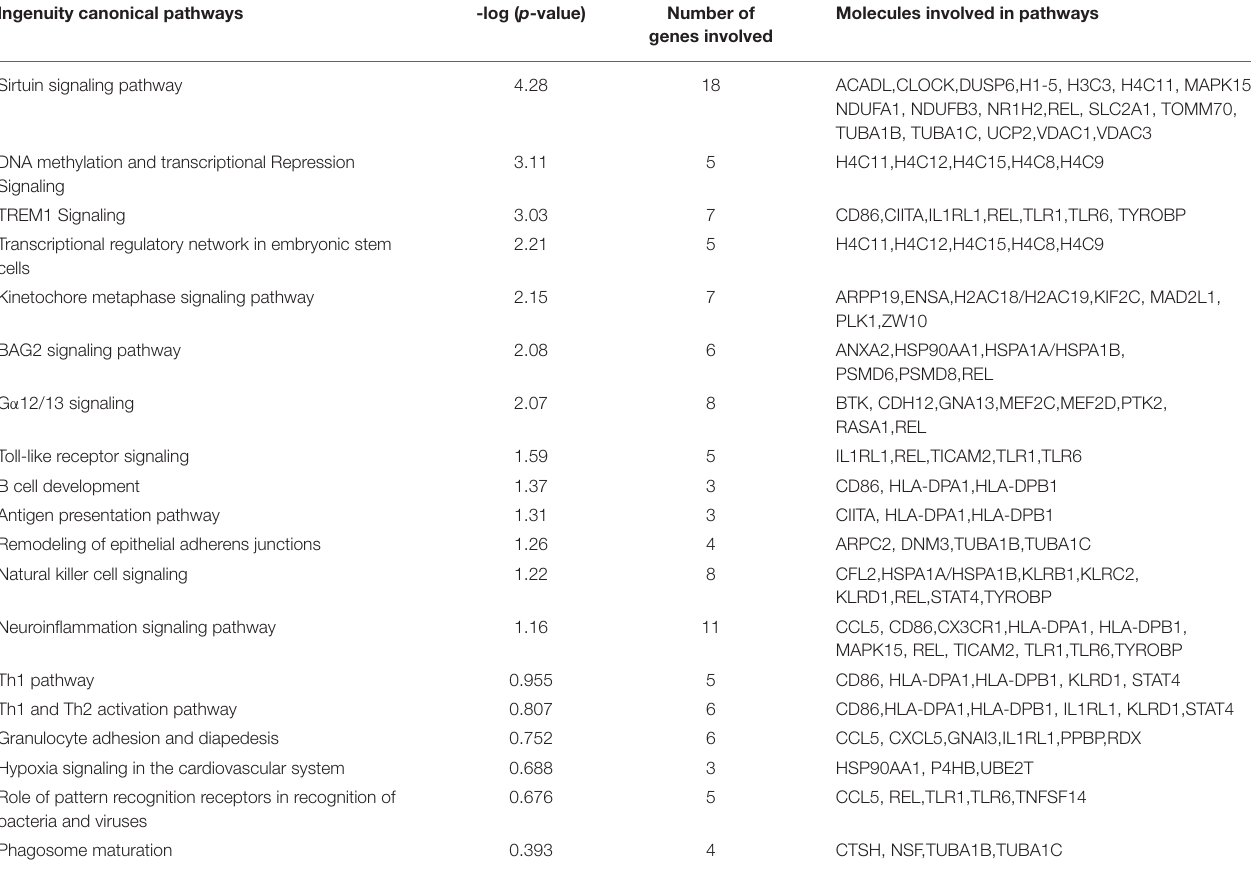
TABLE 3 | Important canonical pathways picked-up by ingenuity pathway analysis of the differentially expressed genes between Covid and control group. Ingenuity canonical pathways -log ( p -value) Number of genes